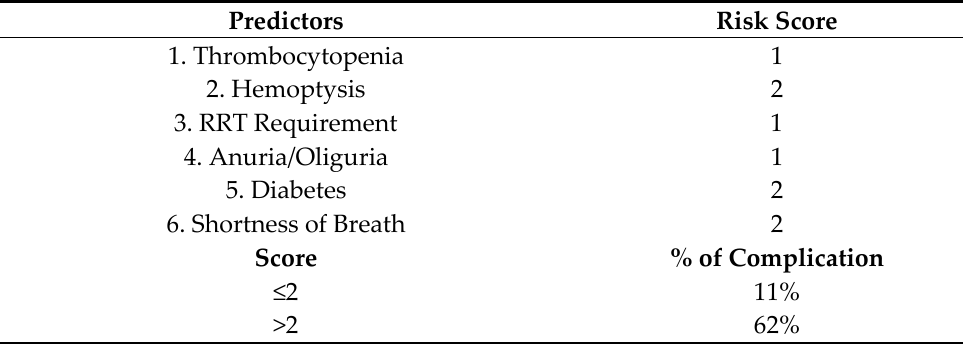
Figure 2. Scoring tool: THe-RADS score. Table 6. Multivariate regression analysis (final model) for the Scoring Index of Pulmonary Complication